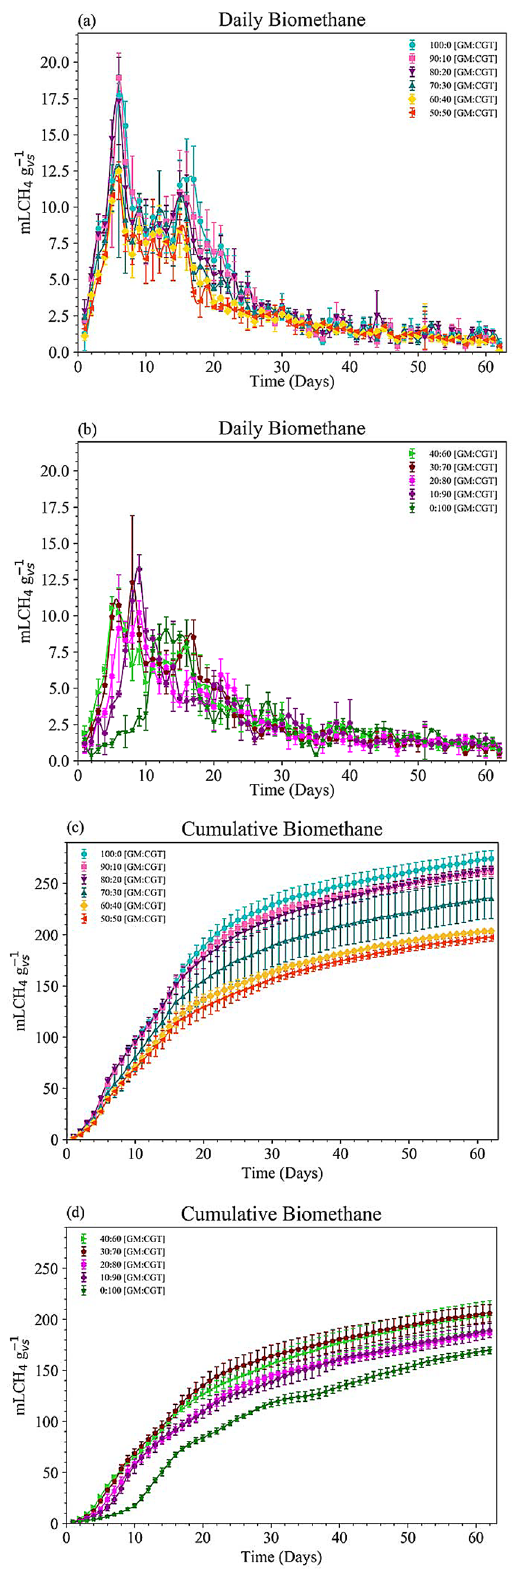
Fig. 1 Daily biomethane yields (mL/g ) for goat manure (GM) and vs cotton gin trash (CGT) mixing ratios of 90:10, 80:20, 70:30, 60:40, 50:50 ( a ); and 40:60, 30:70, 20:80 and 10:90 ( b ). The error bars rep- resent the standard deviation. Each dot on the chart represents the mean of three values. Cumulative biomethane yields (mL/g ) vs for goat manure (GM) and cotton gin trash (CGT) mixing ratios of 100:0, 90:10, 80:20, 70:30, 60:40 and 50:50 ( c ); and 40:60, 30:70, 20:80, 10:90 and 0:100 ( d ). The error bars represent the standard deviation. Each dot on the chart represents the mean of three val- ues